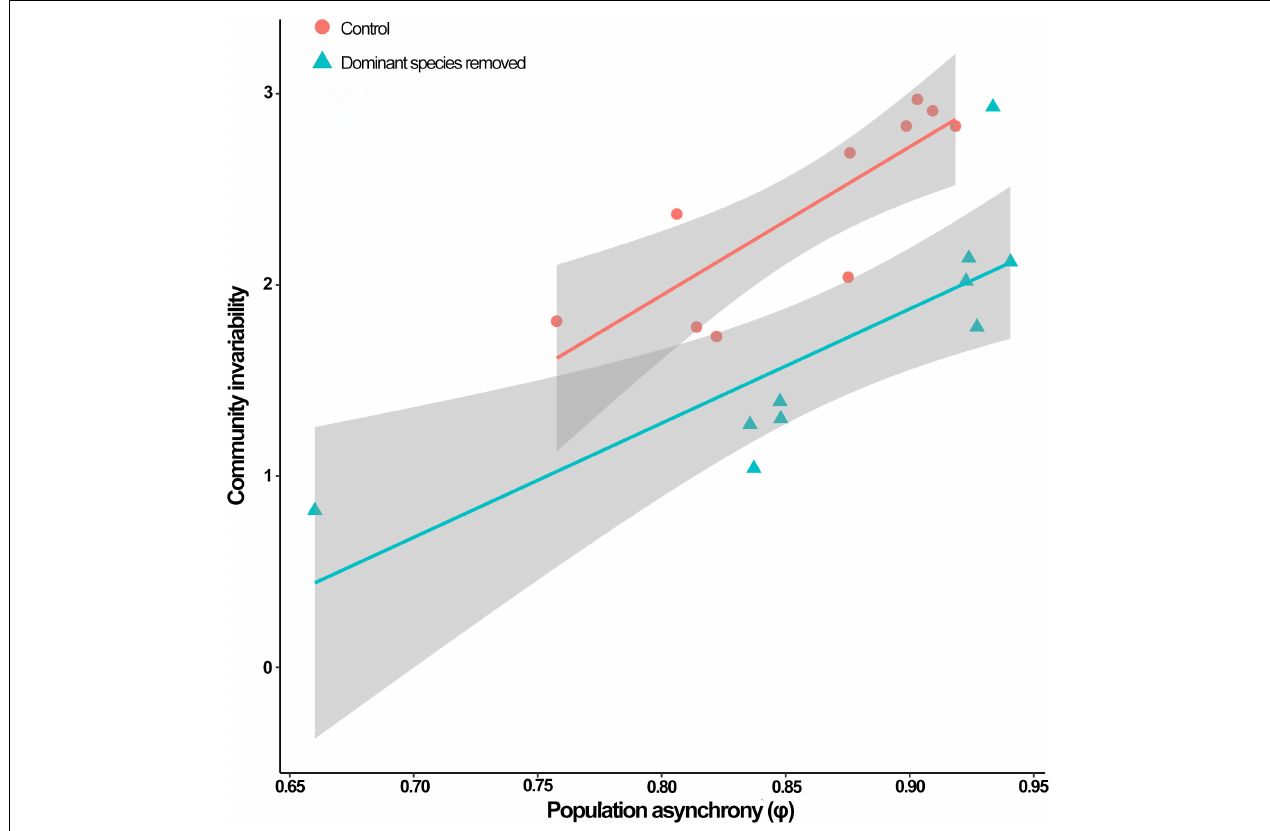
FIGURE 1 | Relationship between population asynchrony and community invariability in control (circles) and disturbed (triangles) experimental intertidal communities from northern-central Chile. Blue and red lines, and gray areas represent predicted values and standard errors, respectively, of community invariability (see model parameters in Table 4 ). Based on 20 experimental plots (10 control and 10